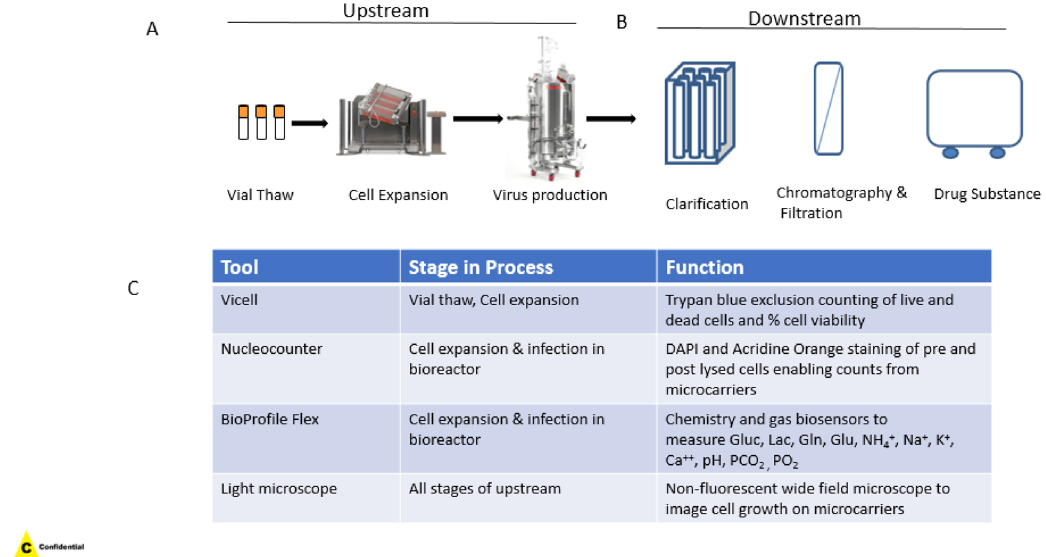
Figure 2. Depiction of a typical live virus manufacturing process. ( A ) Typical upstream process involves vial thaw into cell stacks that allows for optimal cell expansion after which adherent cells are planted on microcarriers to expand in a bioreactor. ViCell or Nucleocounter counts during this stage are used to monitor total and dead cell counts and cell viability. Optimally expanded cells in bioreactors are infected with virus of choice after which the production bioreactor is maintained at standard temperature and pH for virus replication. Analytical tools like Nucleocounter (NC200), BioProfile Flex and light microscopes are used to monitor cell viability, metabolites and cell expansion on microcarriers, as indirect measurements of virus growth and replication during these stages. After a fixed time of virus replication cells are harvested and virus supernatant substance (DS). ( C ) Table of typical in-process analytical tools for live virus